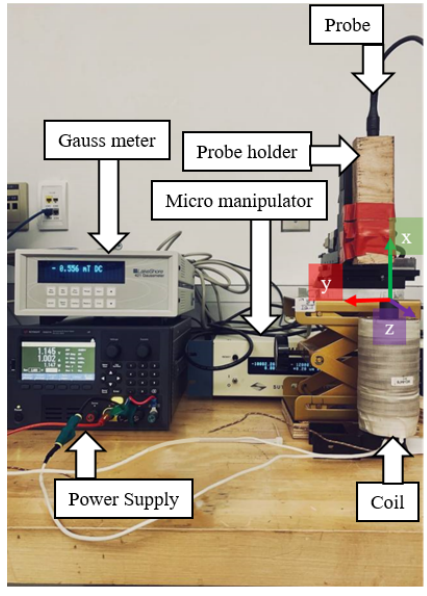
Figure 11. Magnetic field values collection